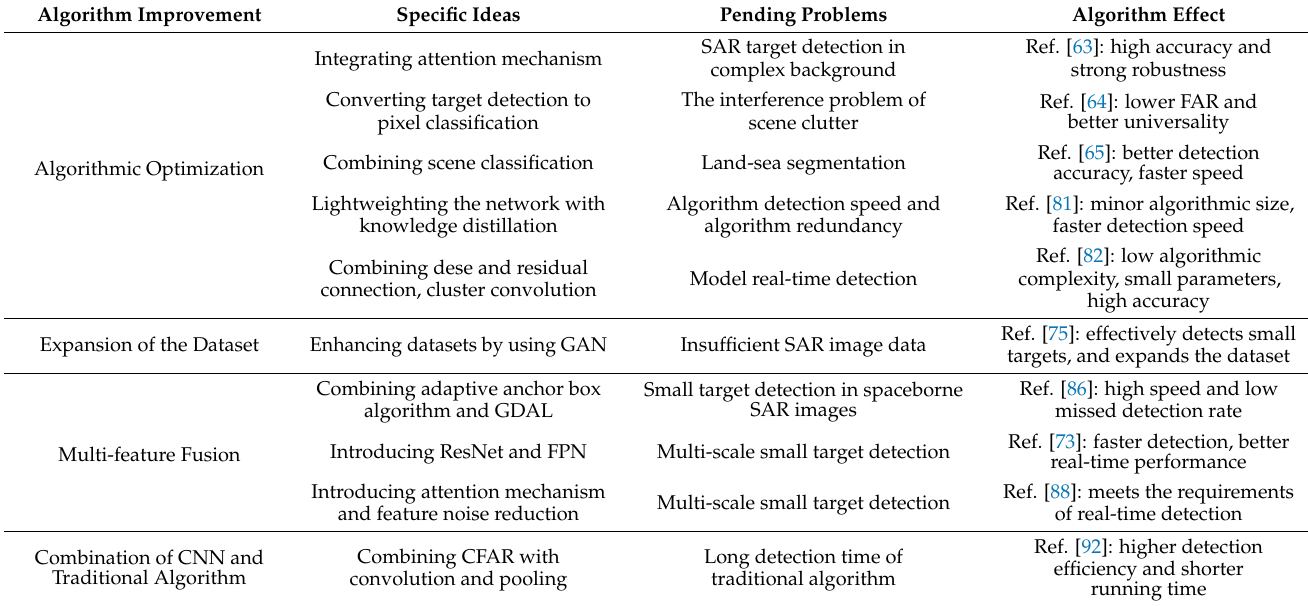
Table 8. Some detection algorithms and detection effects of CNN in SAR image target